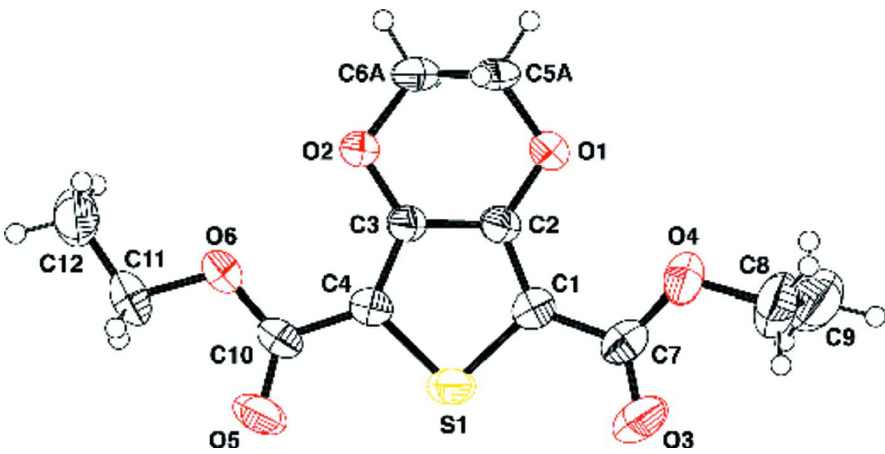
Figure 1 The molecular structure of (I), with atom labels and 50% probability displacement ellipsoids for non-H atoms and H atoms are shown as small spheres of arbitrary radii. The disordered atoms (C5B and C6B) are omitted for clarity.